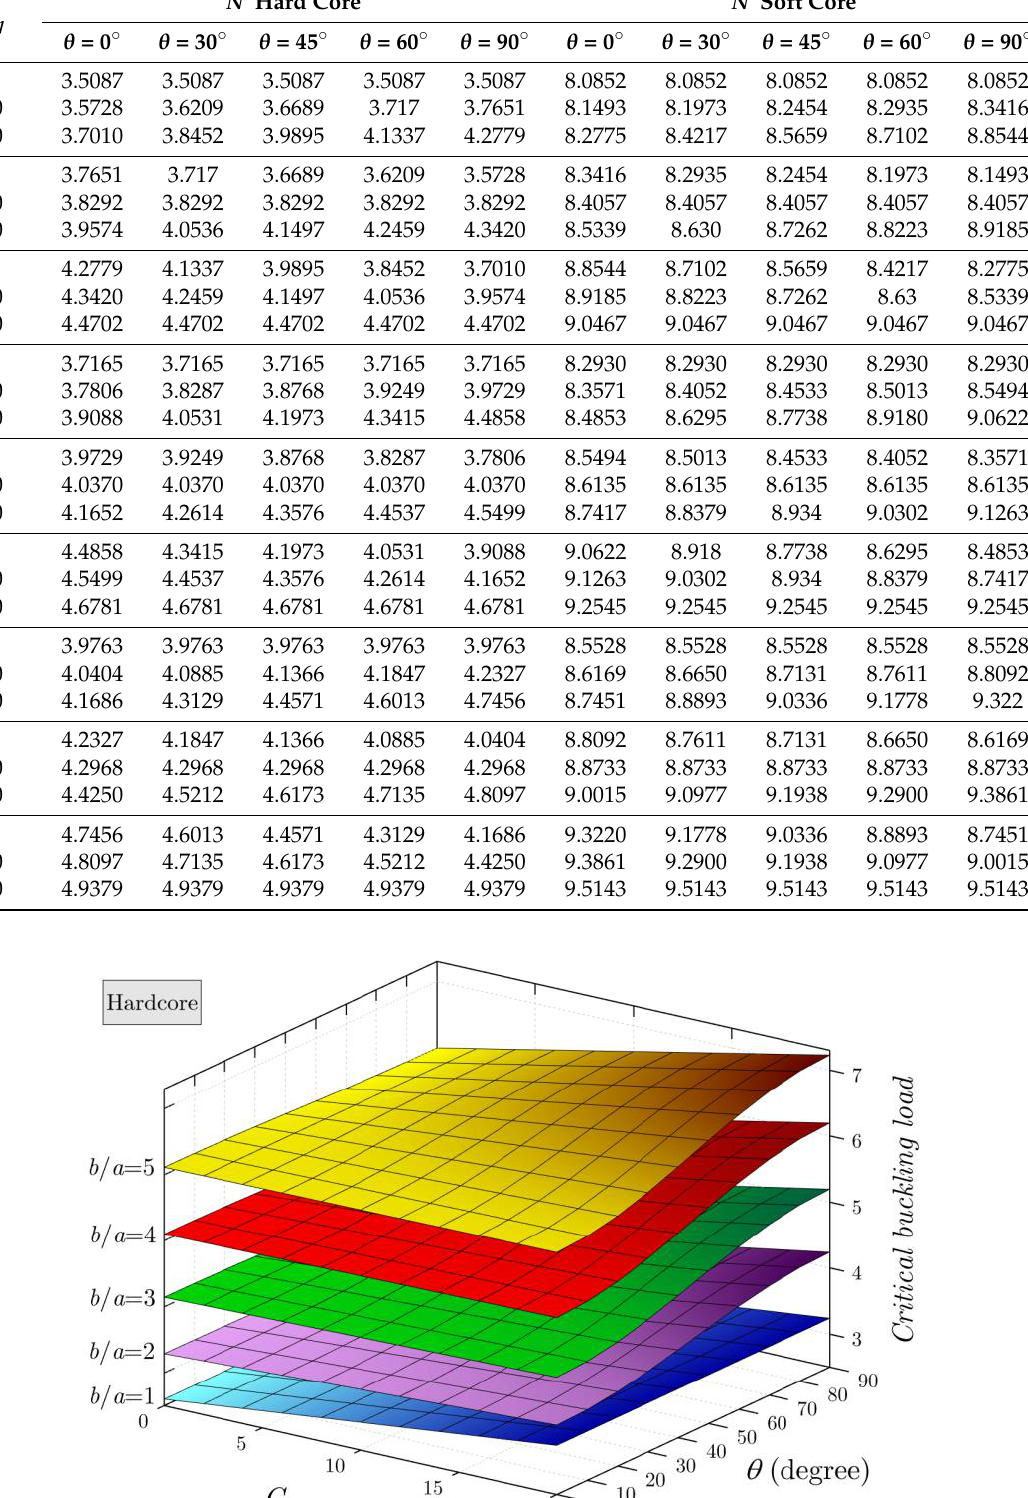
Figure 13. Effect of the orthotropic elastic foundation for various aspect ratios b / a ( SSSS , R = 5, p = k = e = 2, a = 10 h , µ = λ = 0, G η = 2, K w = 10 )